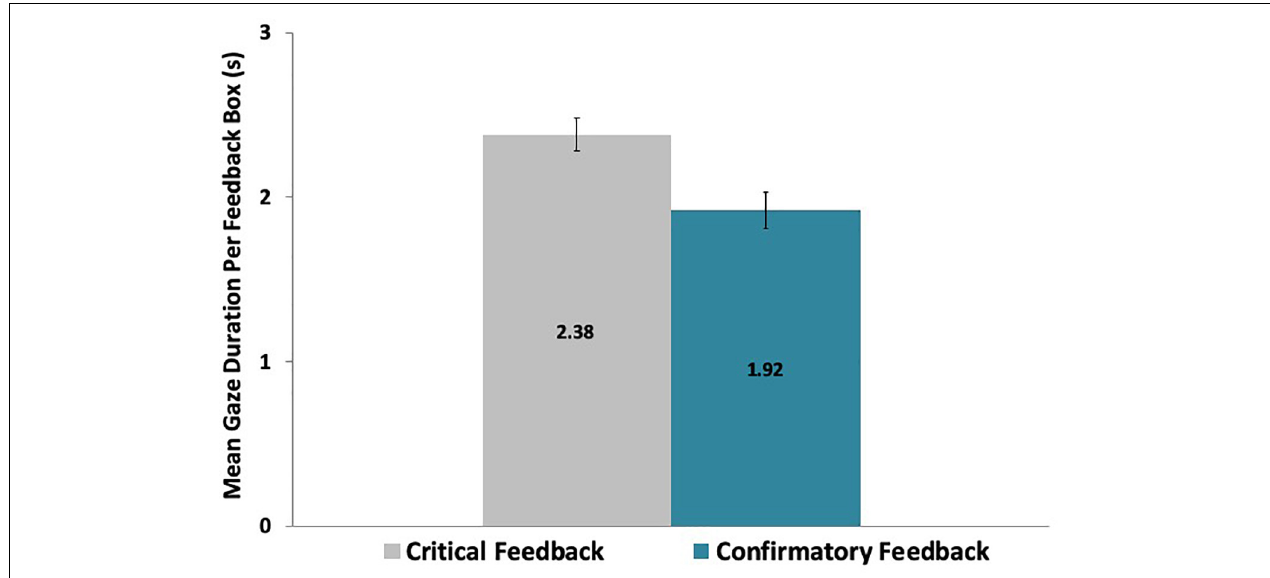
FIGURE 3 | Participants dwelled more on critical than on confirmatory feedback messages across the game.